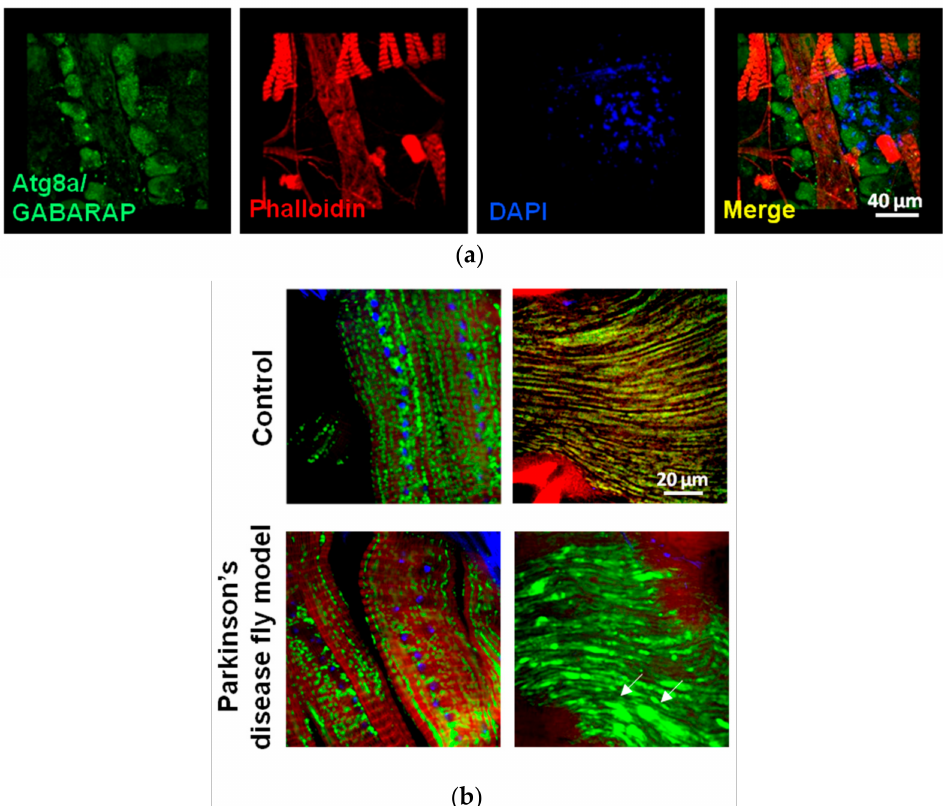
Figure 13. CLSM visualisation ( × 60 magnification) of different stained Drosophila melanogaster tissues. ( a ) Drosophila heart tissue following immunofluorescence staining with an antibody against the Atg8a/GABARAP autophagic protein. ( b ) Different sections of a fly muscle probed with the mitochondrial marker blw/ATP5A (green) in a Parkinson’s disease fly model, showing accumulation of mitochondrial aggregates (arrows) vs. control. In ( a , b ) nuclei and actin were counterstained with DAPI and phalloidin, respectively. In ( a ), Z-stacks with a step size of 1 µ m were taken using identical settings, and each stack consisted of 26 plane